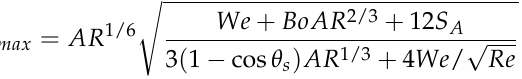
Figure 19. Spread factor evolution for the prolate droplet impact.